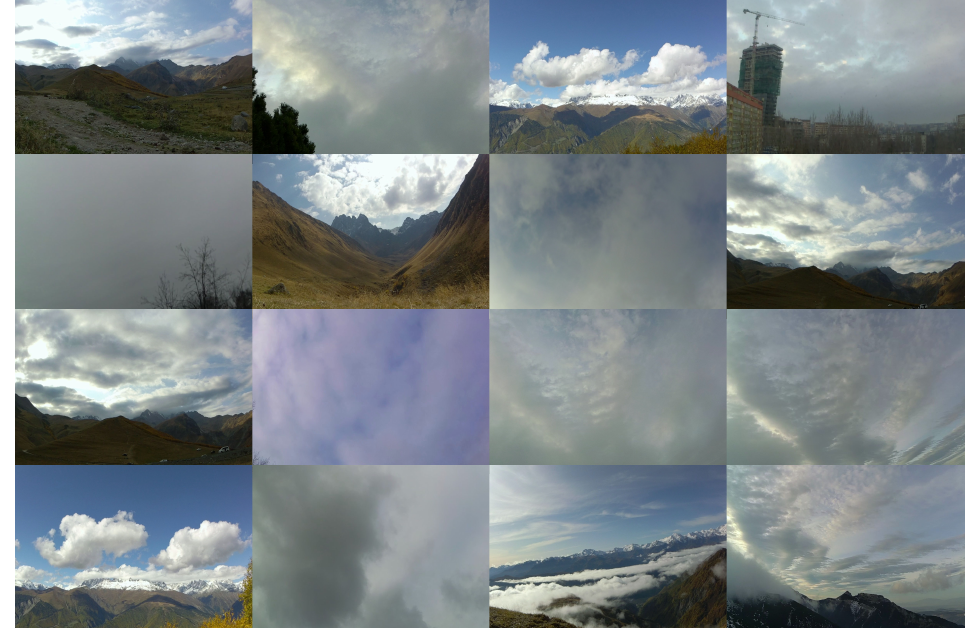
Figure 1. Exemplary video frames of clouds from database. The video sequences were recorded with 30 fps; the resolution was 1920 × 1080